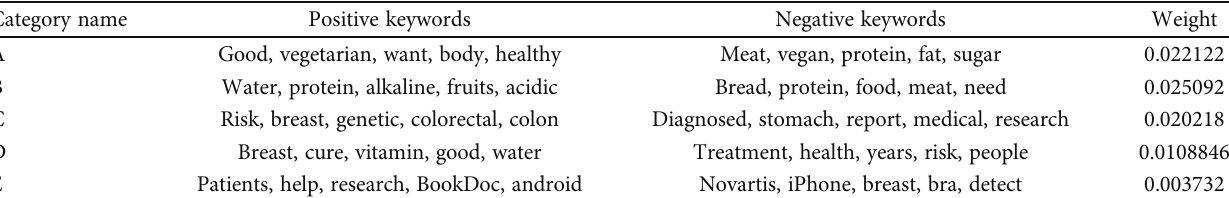
Table 3: Top 10 keywords in each category along with the total